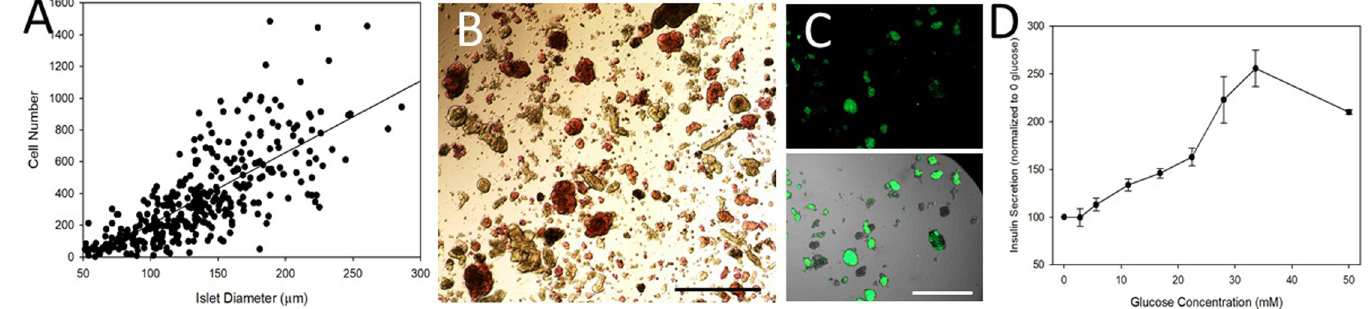
Fig 1. Characterization of canine islets from deceased donors. A) Diameters of 450 freshly-isolated canine islets were measured in the X and Y direction, and subsequently dispersed into single cells, which were counted. The correlation between the canine islet diameters and cell numbers were plotted. The line indicates the linear fit. B) An example of dithizone-stained canine islets with red staining the endocrine cells and the non-cells (tan) indicating exocrine tissue. Scale bar = 500 μ m. C) FluoZin 3 AM was used to further identify canine islets, shown as bright green in the images. The upper image is fluorescence only while the lower image is a brightfield overlay. Scale bar = 500 μ m for all images. D) Static incubations studies of canine islets showed that they responded to increasing concentrations of glucose with higher levels of insulin secretion.